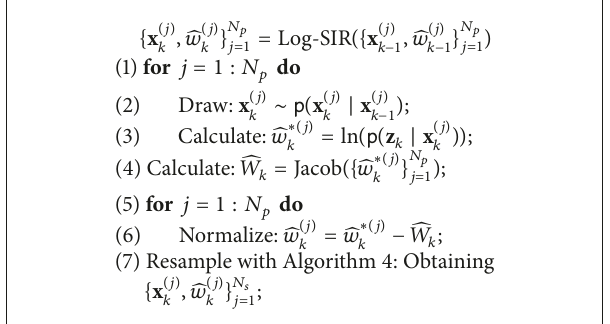
Algorithm 5: SIR-PF in log-domain (SIR Log-PF).